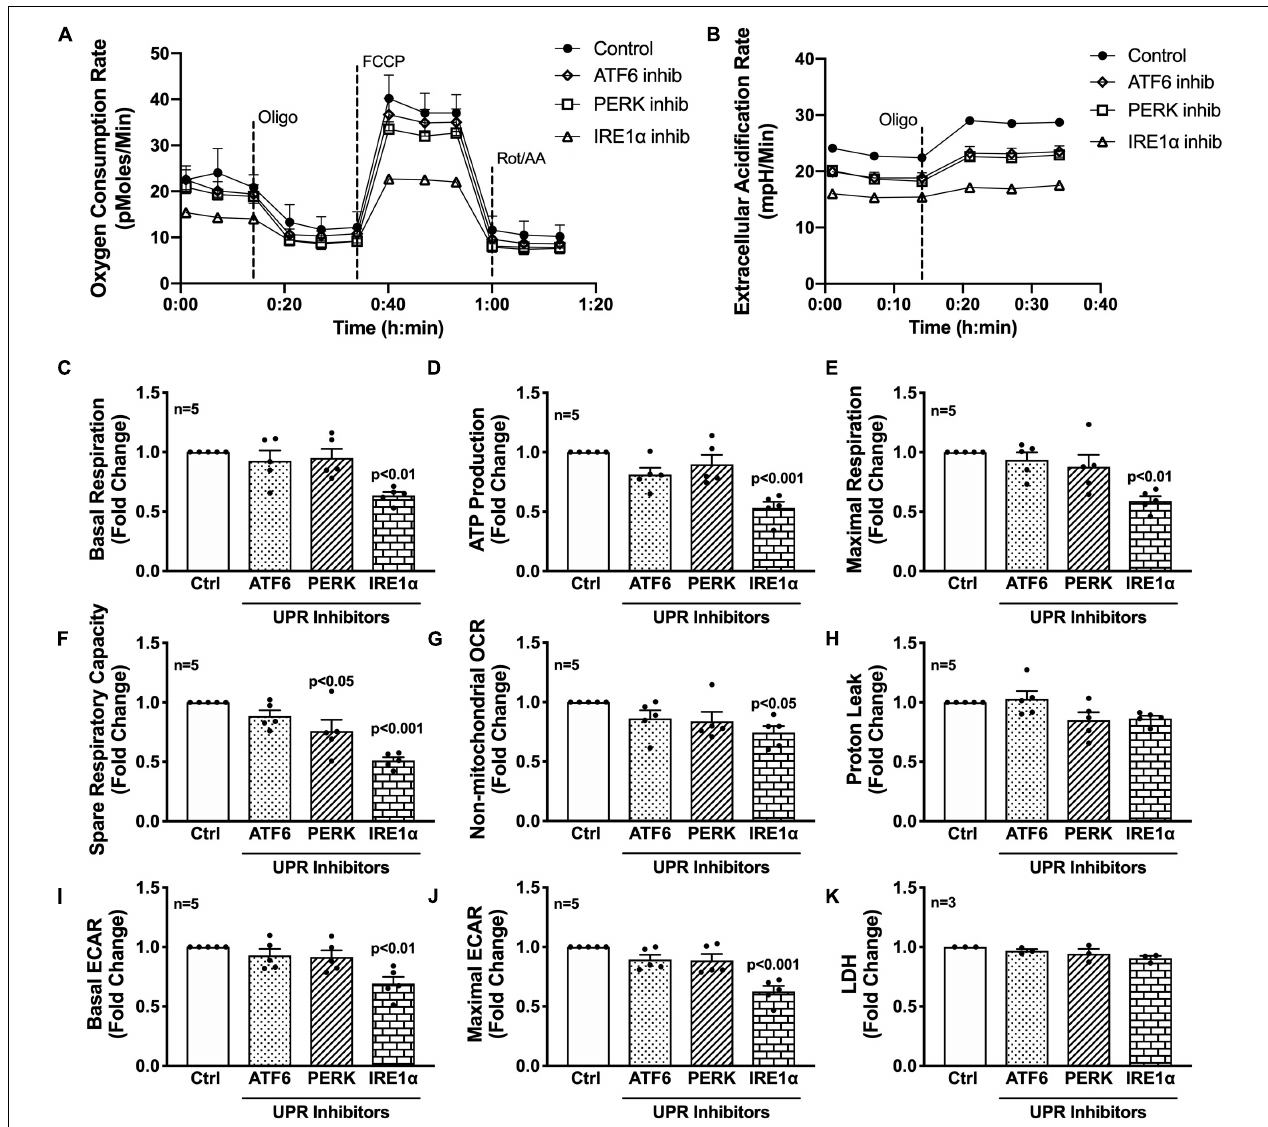
FIGURE 4 | Inhibition of IRE1 α decreases astrocyte metabolic function. (A–K) Astrocytes were treated with pharmacological inhibitors for the three UPR arms [ATF6 (AEBSF; 100 µ M), PERK (GSK2606414; 1 µ M), IRE1 α (STF-083010; 60 µ M)] for 3 h prior to (A–J) Seahorse Mito Stress Test for metabolic assessment or (K) extracellular lactate dehydrogenase (LDH) assay for cytotoxicity. Representative (A) OCR and (B) ECAR profile tracings from a single astrocyte donor were graphed over time. Compiled data from five separate biological donors quantifying fold changes in (C) basal respiration, (D) ATP production, (E) maximal respiration, (F) spare respiratory capacity, (G) non-mitochondrial OCR, (H) proton leak, (I) basal ECAR, and (J) maximal ECAR were graphed for statistical comparisons. Statistical significance was determined via one-way ANOVA followed by Tukey’s post hoc for multiple comparisons. Each dot on graphs represents the averaged data from a minimum of six replicates per biological